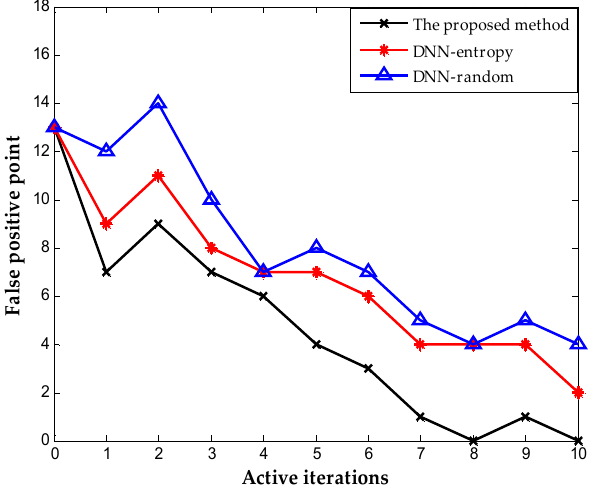
Figure 14. Number of false-positive point obtained on TE dataset.